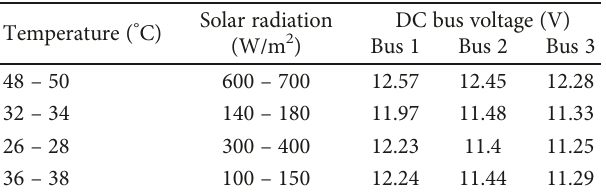
Table 3: Distribution losses of multiple-sources con fi guration. Temperature